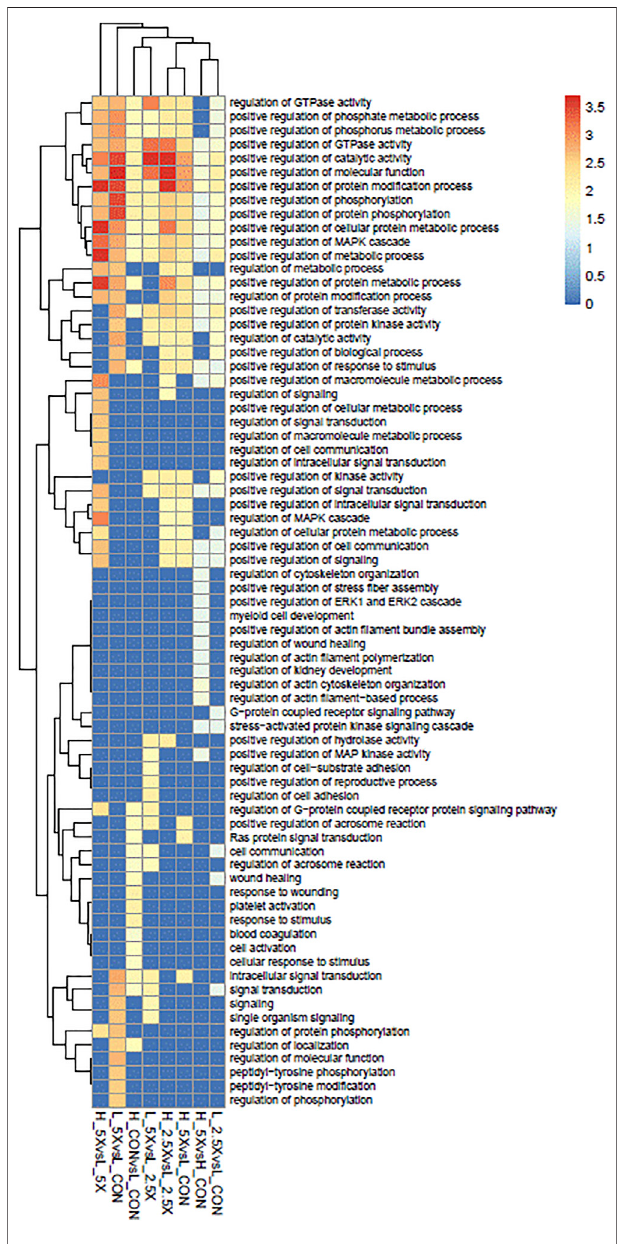
FIGURE 6 | Over-represented biological processes (BPs) of genes with differentially methylated cytosines from embryonic tracheal fi broblast cells treated with different levels of glucose and epigenetic modi fi ers. The plot is color-coded based on -log10 (false discovery rate) of different BPs.